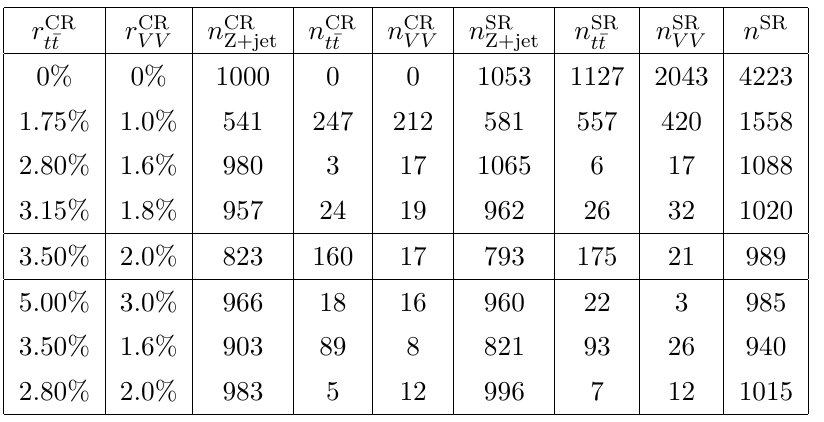
Table 4 . Number of events selected by the classifier from the different background classes in the signal and control region for different compositions of the control region. There are no anomalous events ( f SR = 0 ) and we have r SR = 3 . 5% and r SR = 2% V V t ¯ t